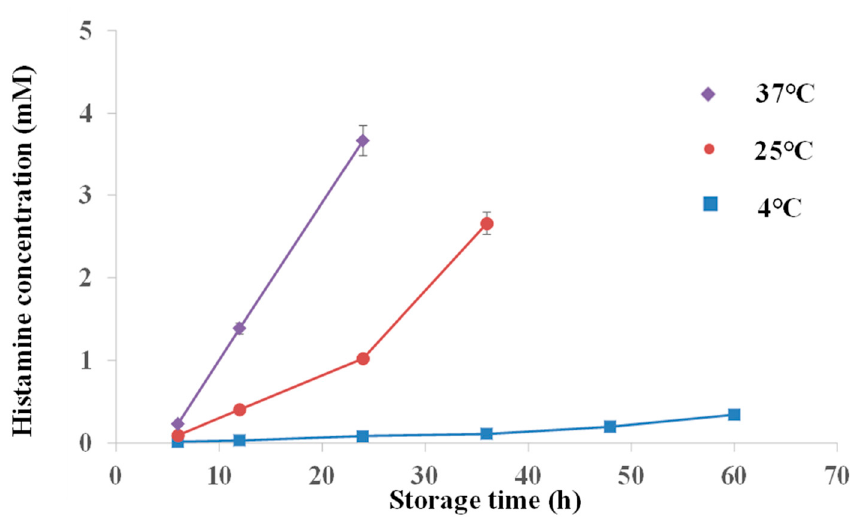
Figure 6. Histamine concentration determination with mackerel fish stored at 4 °C, 25 °C and 37 °C over time.